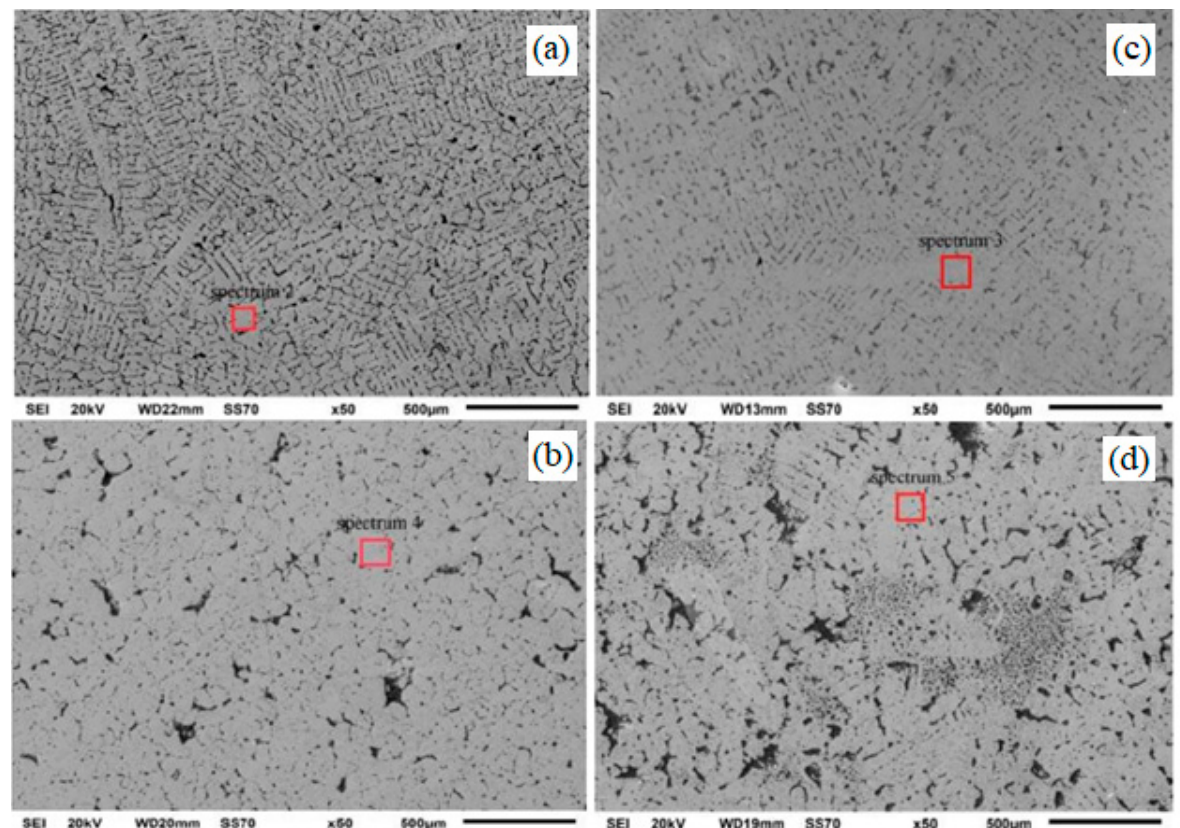
Figure 13. Solidification structure of alloy, treated with different pulse current: ( a ) I = 800 A; (b) I = 1000 A; ( c ) I = 1200 A; and ( d ) I = 1400 A [37].